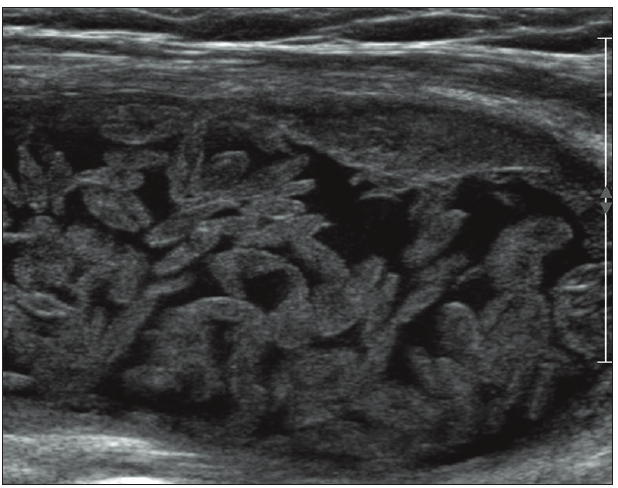
Fig. 1. Ultrasound (linear 12 MHz transducer) of the left shoulder shows numerous well-defined iso-echoic oval lesions with no acoustic shadowing in a distended subacromial-subdeltoid bursa. There was marked bursa wall thickening and a moderate amount of hypoechoic fluid.